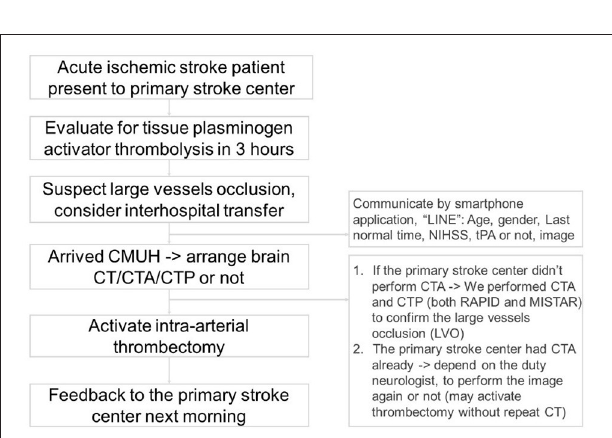
FIGURE 3 | The workflow of interhospital transfer of patients for intra-arterial